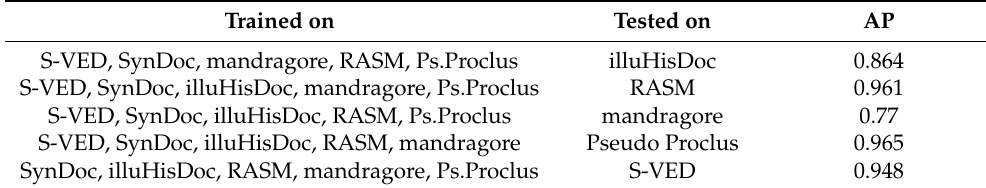
Table 5. Cross validation results, where the YOLOv5 model was trained on all five data sets except the respective test set. A resolution of 640 × 640 was used for all data